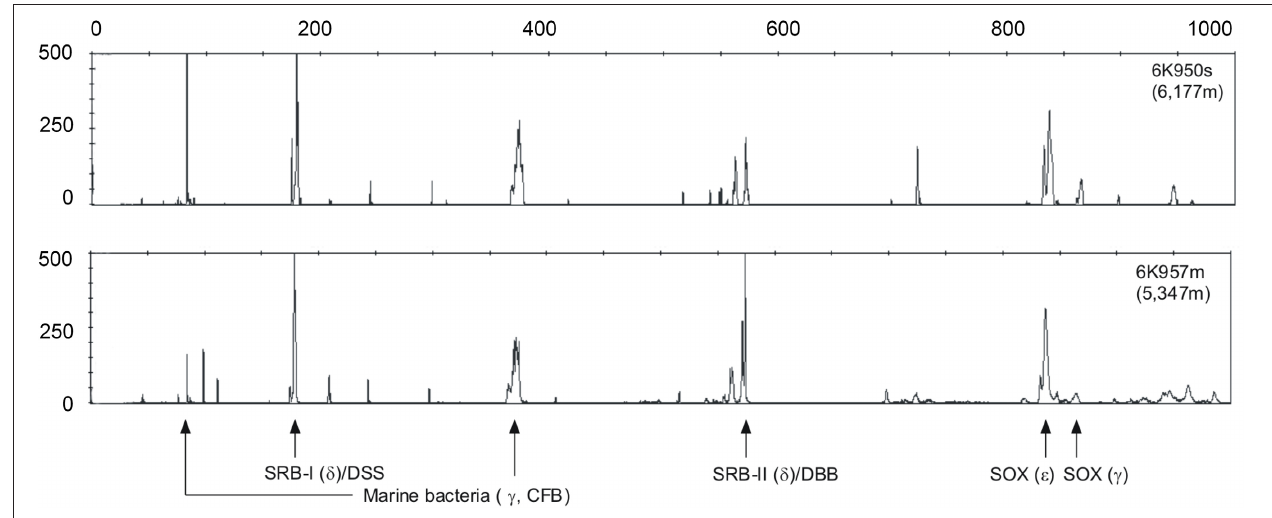
FIGURE 3 | Examples of bacterial T-RFLP electrophoretograms from Station 1 (upper profile) and Station 2 (lower profile). γ , δ and ε indicate the corresponding proteobacterial groups, and Sox and SRB indicate the